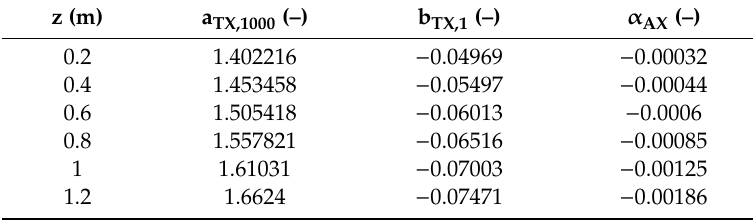
Table A7. SHML parameters calculated based on input parameters and constants for the footing settlement